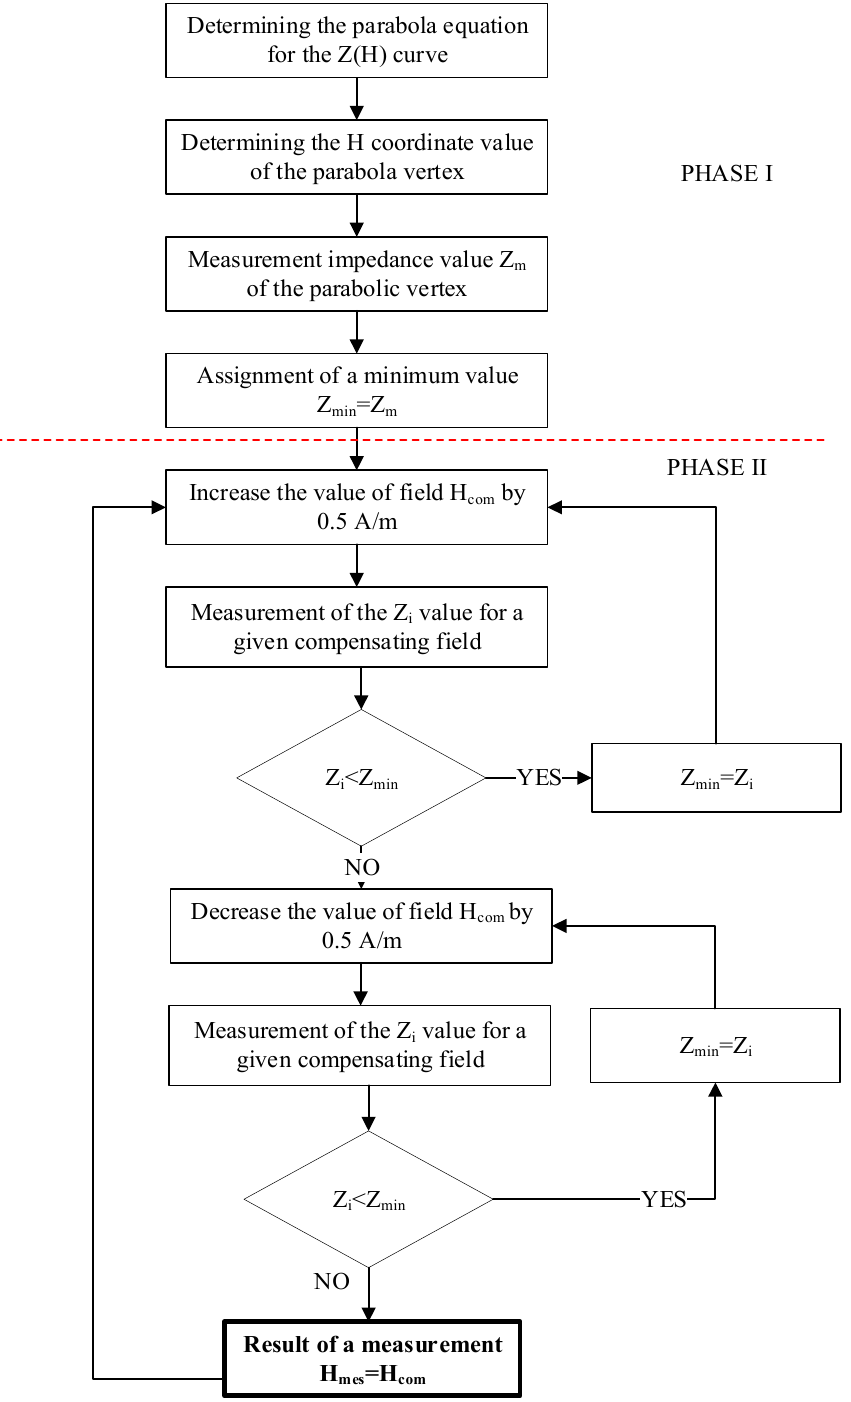
Figure 8. Block diagram of the second stage of the proposed sensor algorithm.